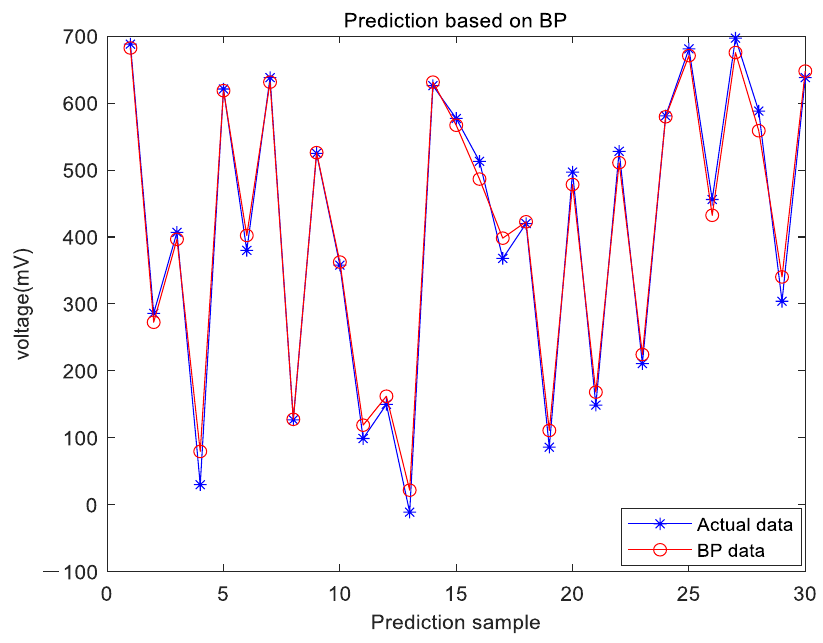
Figure 8. Prediction based on BP.